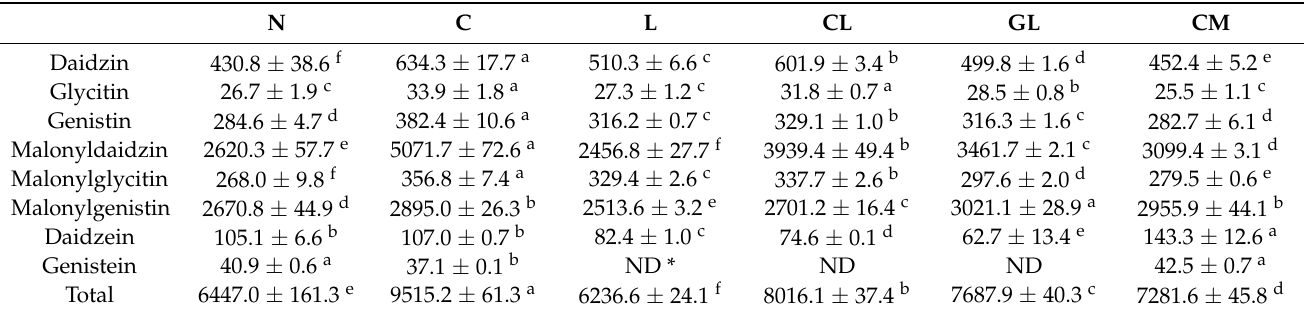
Table 2. Contents of individual and total isoflavonoids ( µ g/g DW) during germination (n = 3) in soybean sprouts.